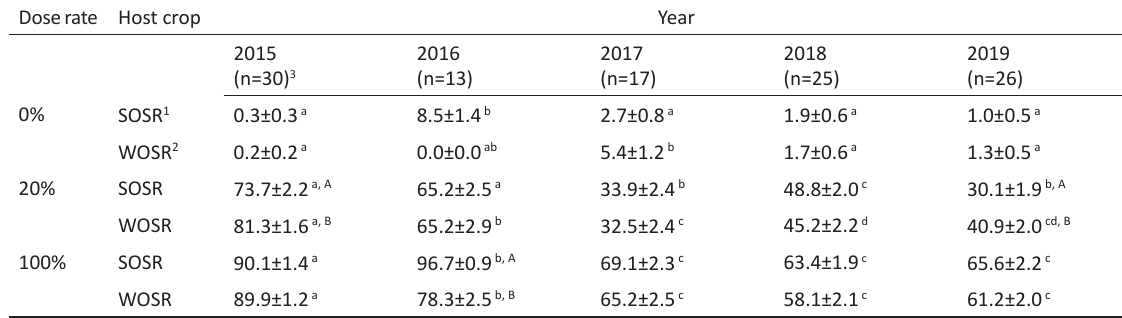
Dose rate Host crop